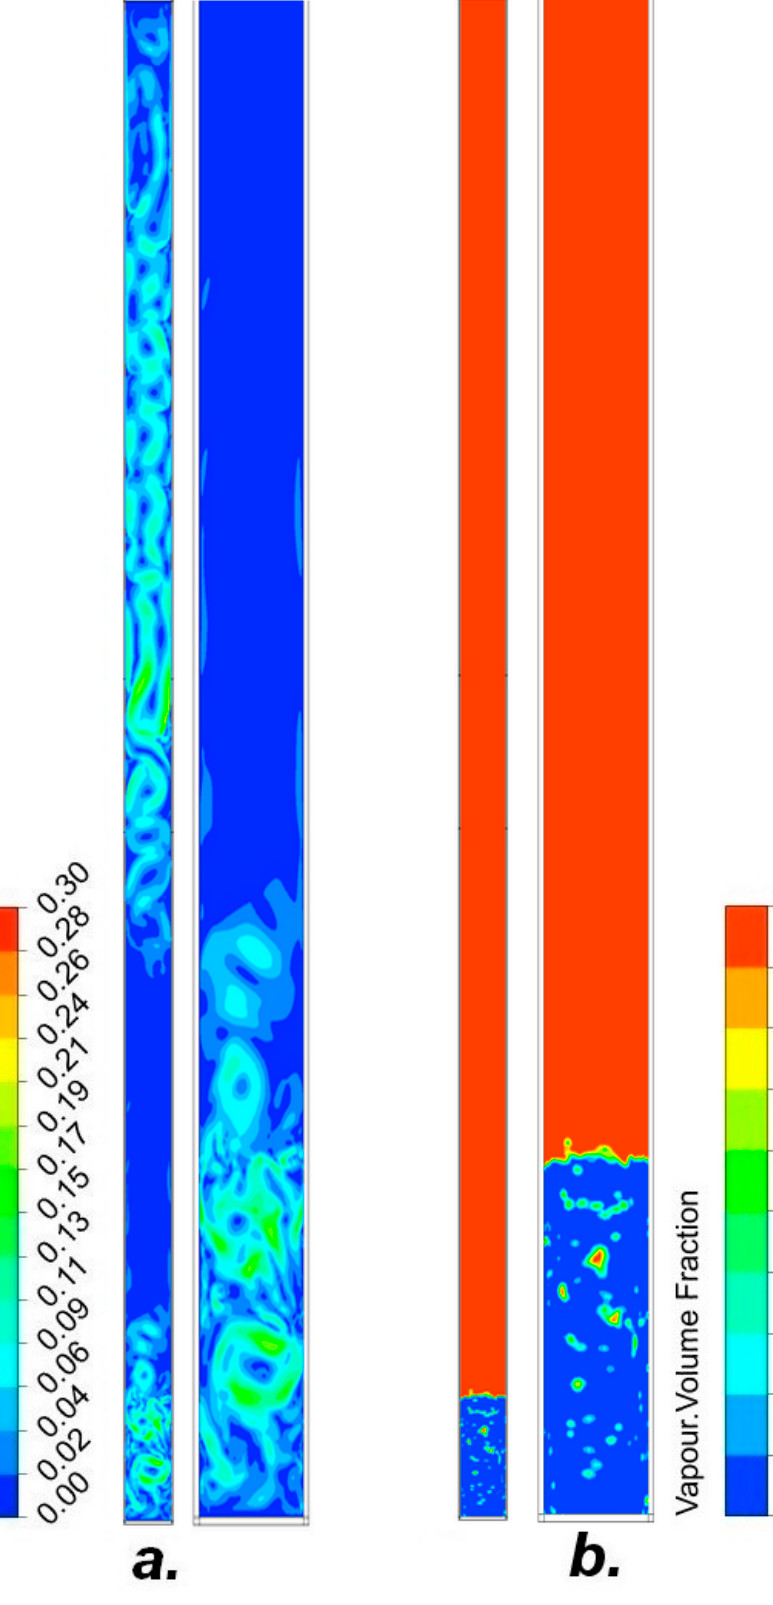
Figure 23. ( a ) Fluid velocity in the total heat pipe and in the condenser section, ( b ) the volume fraction of steam in the total heat pipe and in the evaporator section.